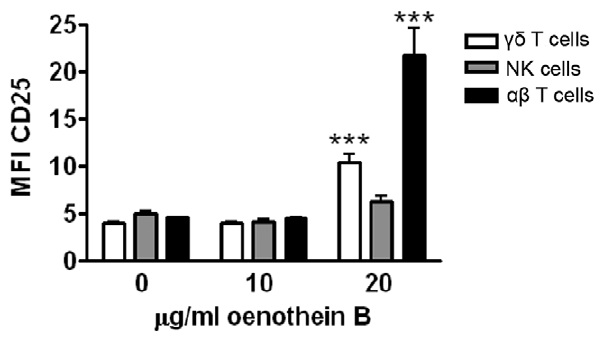
Figure 2. Oenothein B induces CD25 on human T cells. Human PBMCs (10 5 cells/well) were treated with the indicated concentrations of oenothein B in X-VIVO medium for 42 hrs. CD25 expression on lymphocytes, which included cd T cells (CD3 + / cd TCR + ), NK cells (CD3 2 /CD56 + ), and ab T cells (CD3 + / cd TCR-), was then measured by flow cytometry. The graph represents pooled data from 5 individuals. Each treatment was analyzed in duplicate and error bars indicate SEM. Significance compared to untreated cells (0 m g/ml) was determined by One-way ANOVA with Bonferroni post-test. *p , 0.05, **p , 0.01, ***p , 0.001.